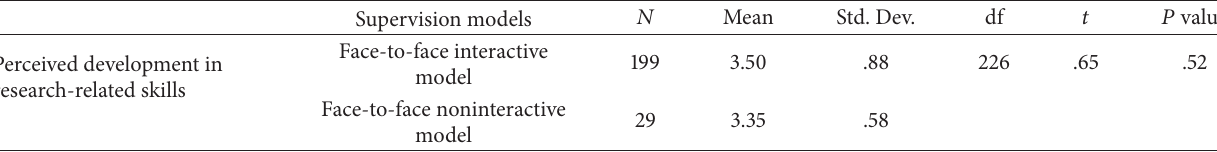
Table 5: 𝑡 -test for difference in doctoral students’ research skill development by two models of dissertation supervision. Supervision